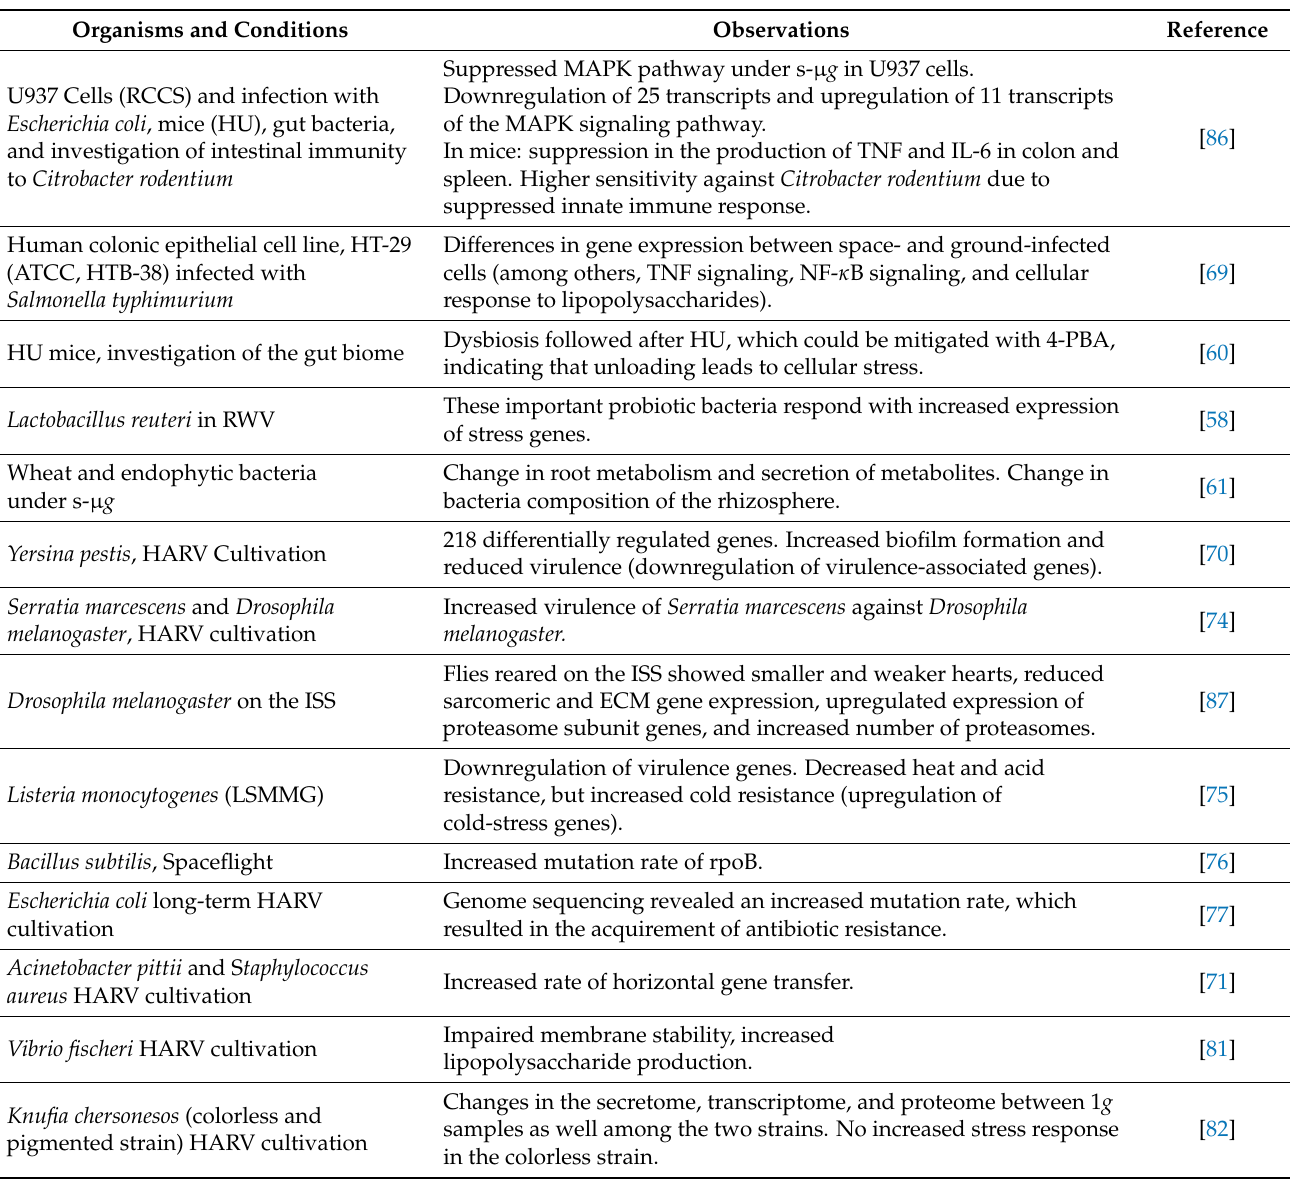
Table 2. Changes in gene regulation in microorganisms and animals exposed to microgravity